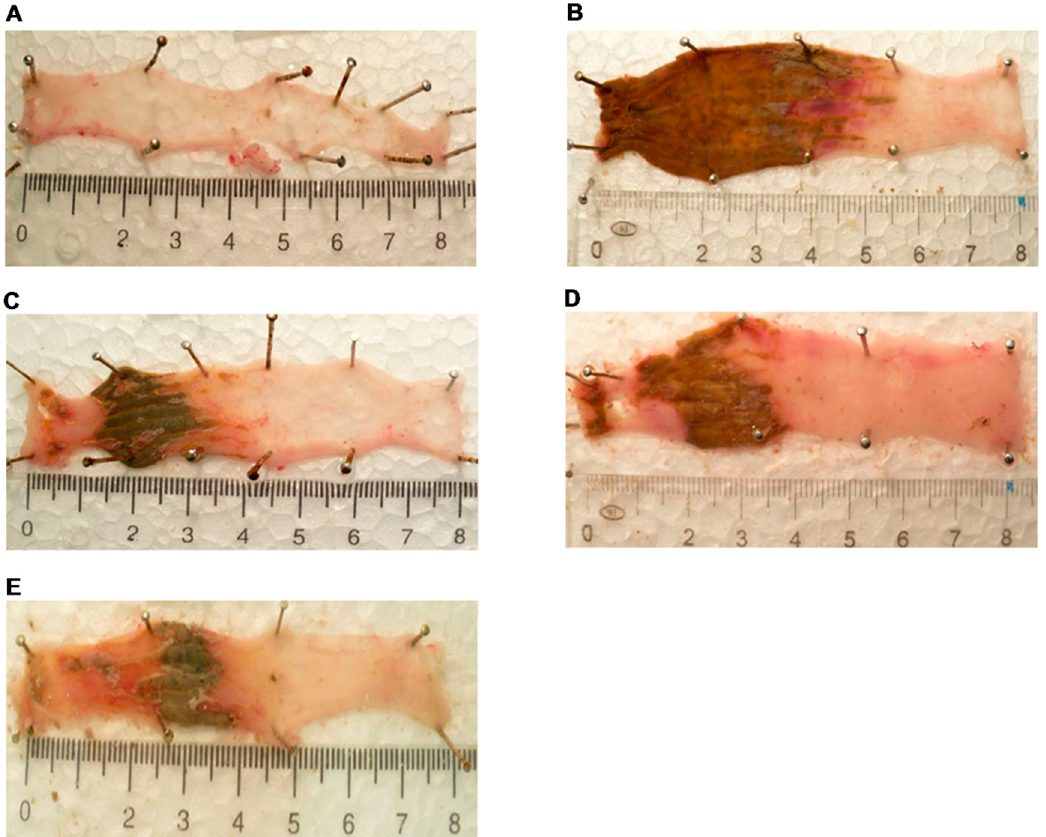
Figure 2. The 2,4,6-trinitrobenzenesulphonic acid (TNBS)-induced colitis developed to a macroscopic inflammatory damage in the colon of rats. Experimental groups were as follows: ( A ) Absolute control, ( B ) TNBS-induced colitis, ( C ) TNBS + C142, ( D ) TNBS + C150, and ( E ) TNBS + Infliximab. Representative images of 8 cm long fresh colon preparations after treatments. Colitis was induced as described in Section 4.2 in Materials and Methods.